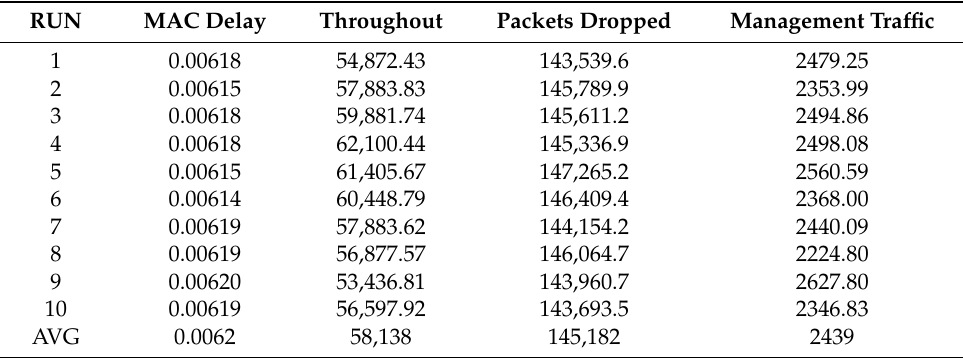
Table 9. Randomized Scenario ACO.